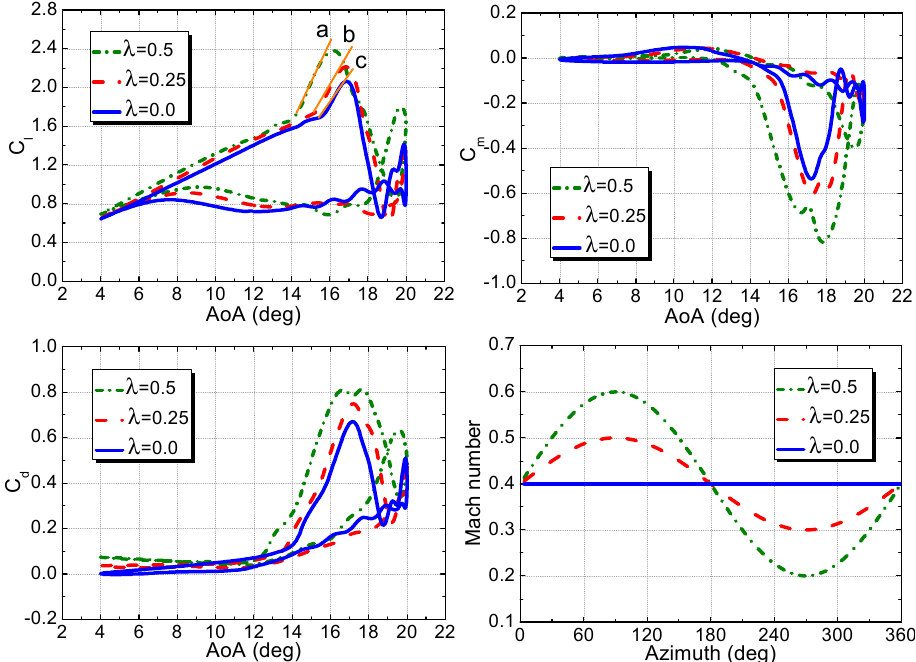
Figure 12. Comparisons of aerodynamic loads at di ff erent oscillating velocities (k = 0.075, α = 12.0 ◦ + 8.0 ◦ sin ( ω t + π ) Table 3. Peaks of the aerodynamic loads.